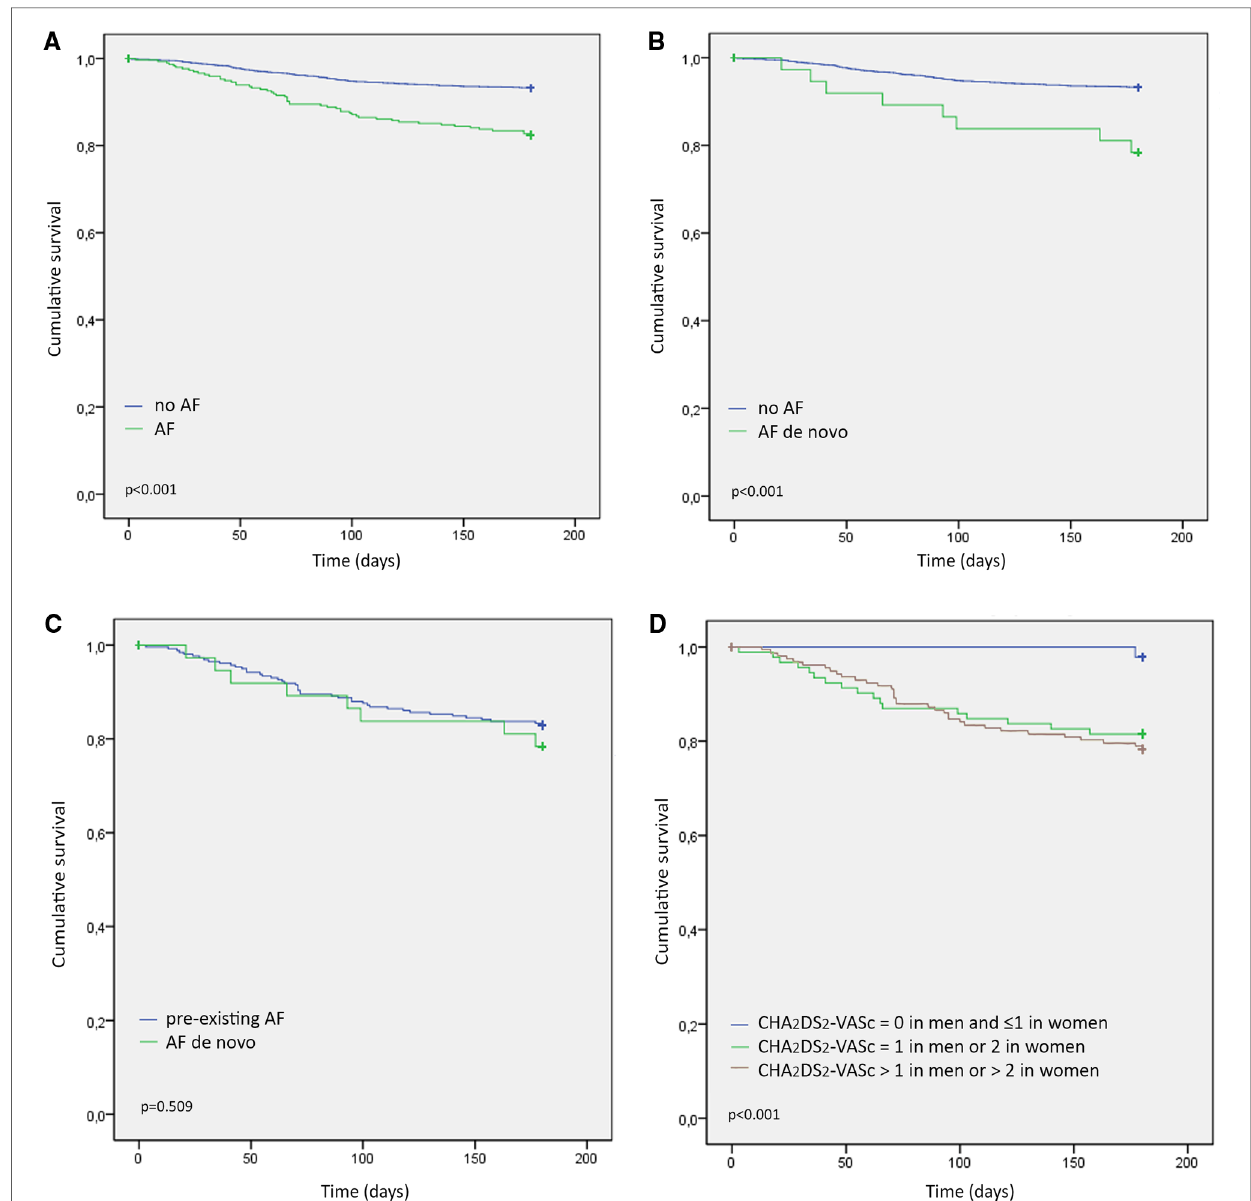
FIGURE 5 Kaplan – meier 180-day post-discharge survival probability strati fi ed by: ( A ) the presence of AF, ( B ) AF de novo vs. without AF, ( C ). AF de novo vs. pre- existing AF, ( D ).